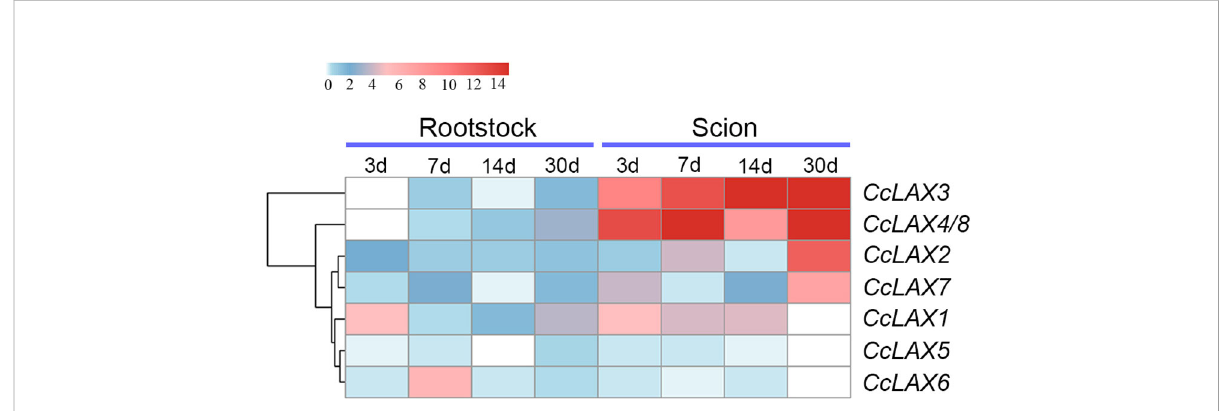
FIGURE 7 Heatmap of CcAUX/LAX gene expressions at different grafting stages. Red and blue represent relatively high and low expression compared to the control, respectively. The values used in the heat map were the mean of three replicates, and normalized to the control sample. The control samples were scions and rootstocks collected at day 0 of